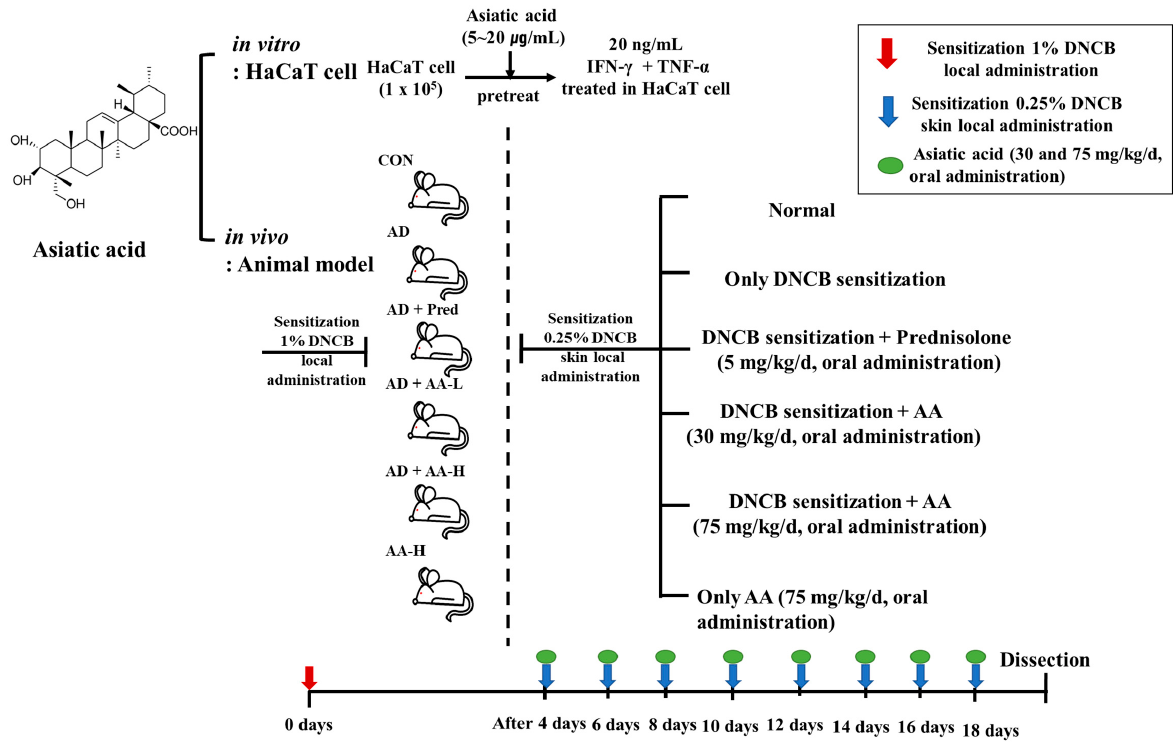
Figure 1. To determine the effect of asiatic acid (AA) in vitro in 20 ng/mL IFN- γ + TNF- α -treated HaCaT cells pretreated with 5–20 µg/mL AA and in a 1% 2,4-dinitrochlorobenzene (DNCB)-induced atopic dermatitis (AD) animal model. AD mice were randomly divided into six groups ( n = 7 per group). DNCB promoted AD skin lesions in the mice. Briefly, 200 µL 0.25% DNCB was applied to each mouse's ear and, after 4 d, application was repeated once every 2 d for 18 d. AA (30 and 75 mg/kg/d) was orally administered. The AA-H mice were orally administered 75 mg/kg/d AA. Prednisolone was orally administered (5 mg/kg/d).